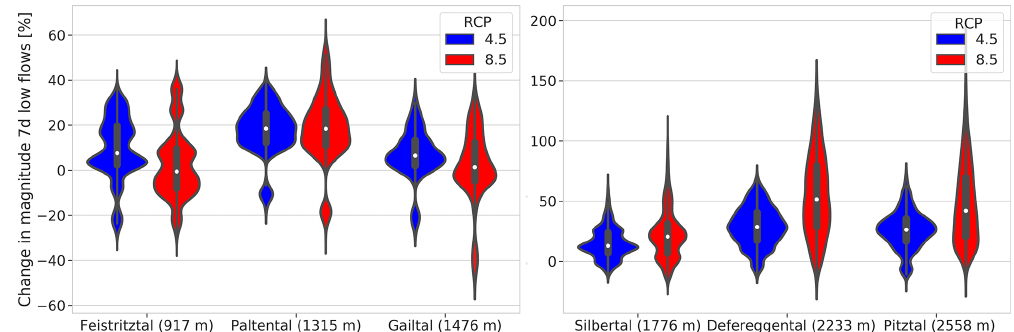
Figure 14. The relative change in magnitude of annual minimum 7d flows for the late 21st century (2071–2100 vs. 1981–2010). Note the different scales for low- and high-elevation